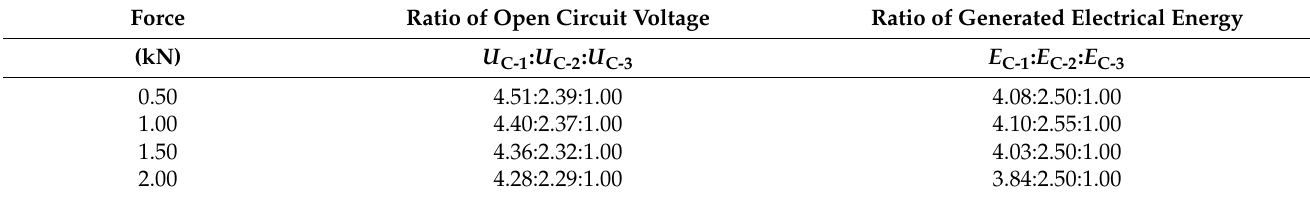
Table 9. The proportions of the voltage and the generated electrical energy in Test C.